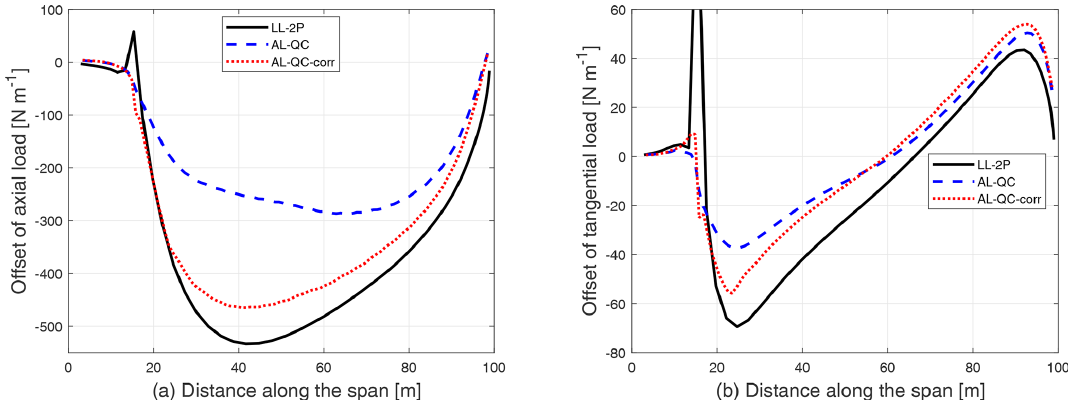
Figure 17. Comparison of the difference in axial load (a) and tangential load (b) of the straight blade with 15 ◦ of upwind coning compared to the straight blade without coning calculated from LL-2P, AL without the one-point correction (AL-QC) and AL with the one-point correction (AL-QC-corr).